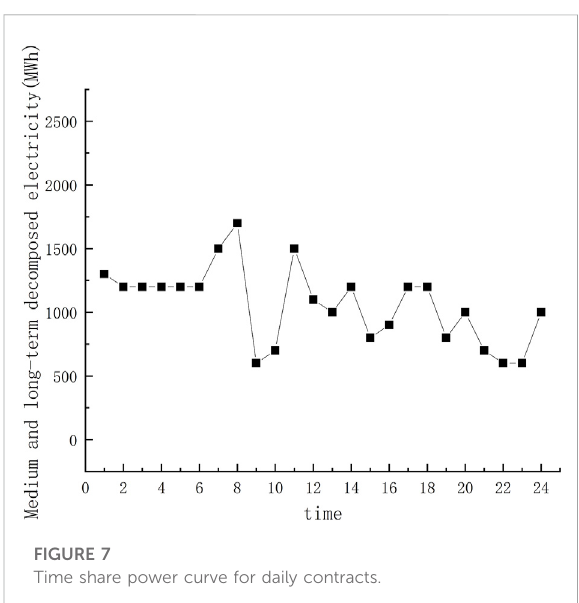
FIGURE 8 MLTM decomposition of PSPP